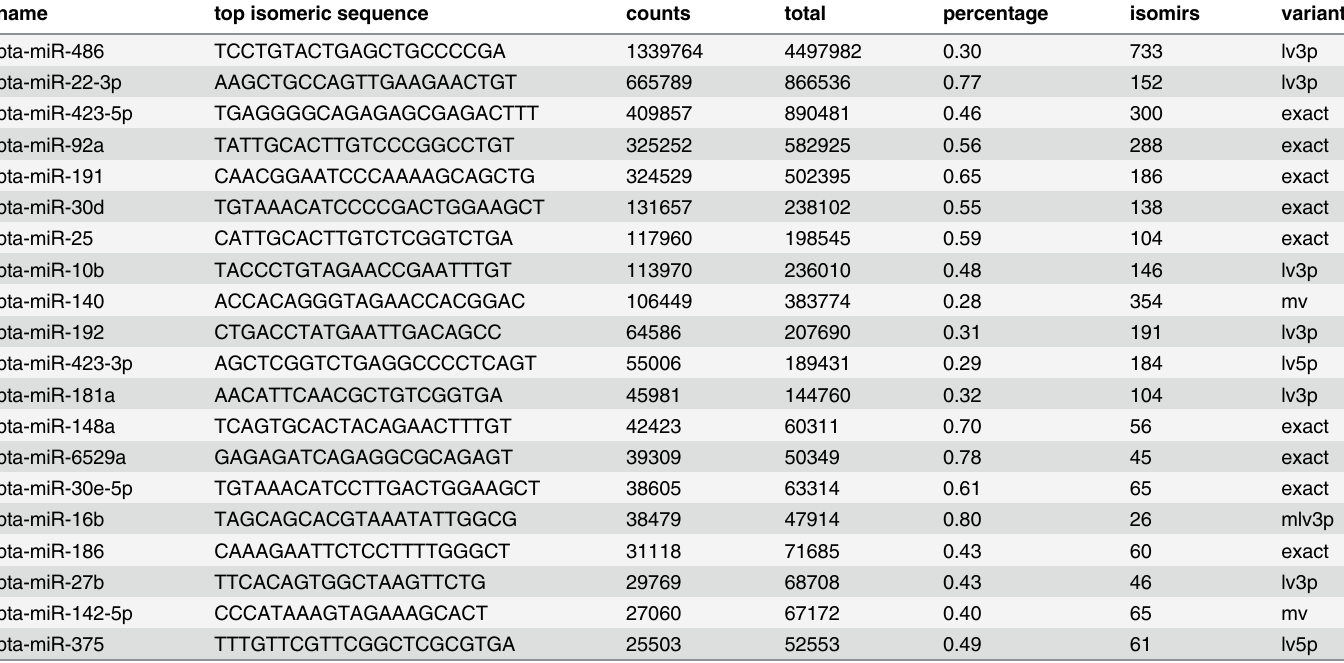
Table 1. Top 20 dominant isomiRs across all samples. Those not marked as 'exact' variants are different from the canonical miRBase sequence. Variants are named using the sRNAbench nomenclature.